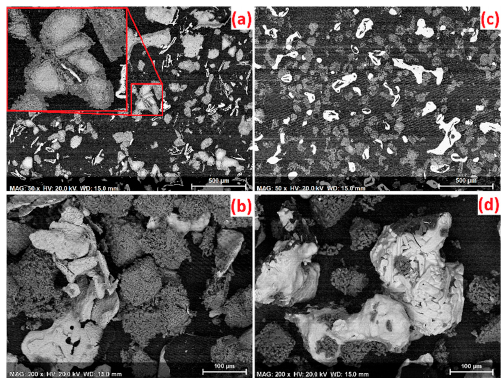
Figure 8. Backscattered electron micrographs of the products formed at 1200 °C ( a , b ), and 1400 °C ( c , d ). Photomicrographs ( a , c ) represent polished section surfaces while ( b , d ) show surface morphologies of the reduced products.